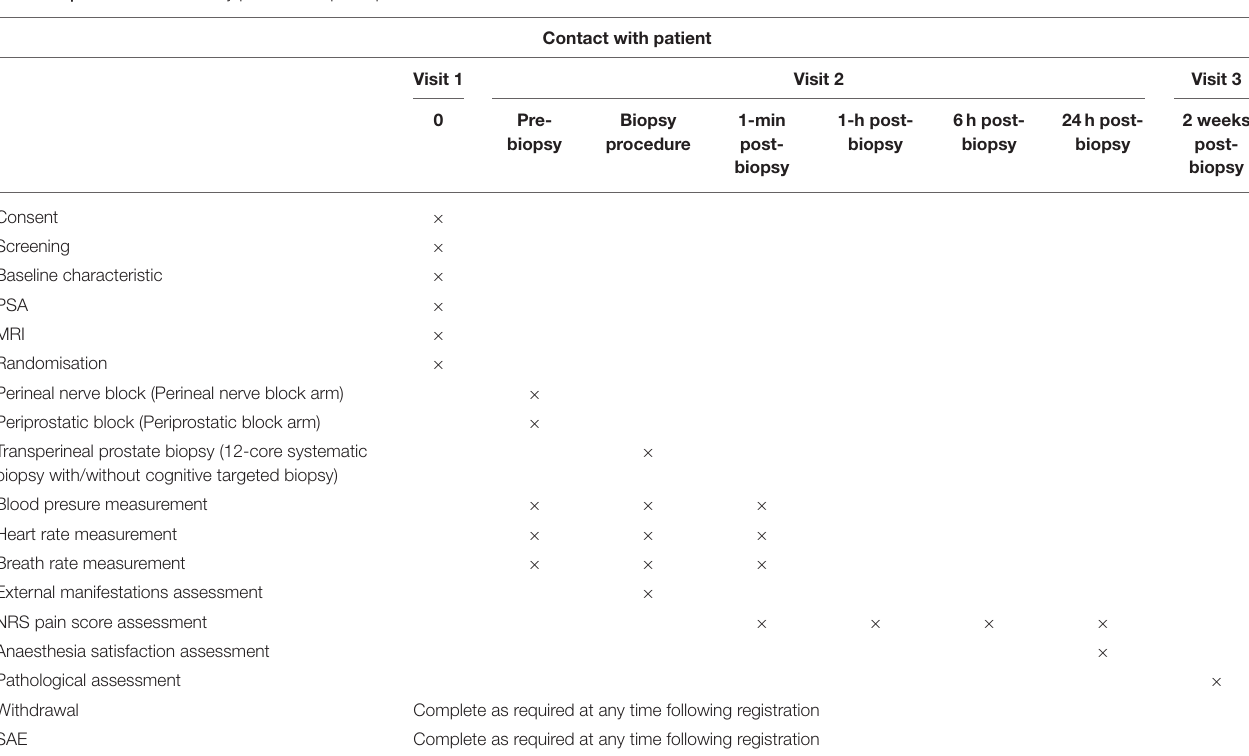
TABLE 1 | Timeline of the study protocol for